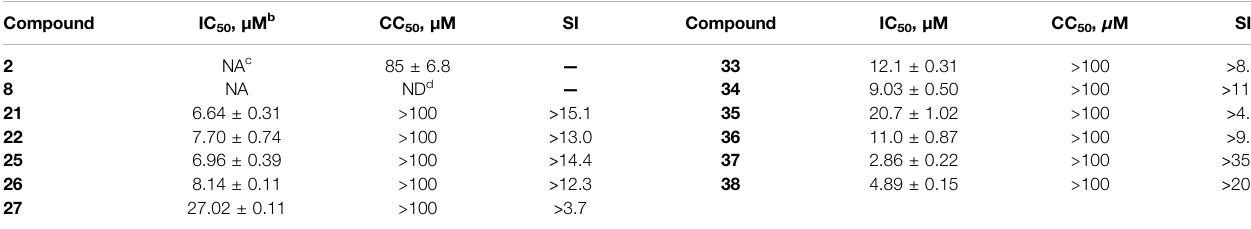
TABLE 2 | In vitro anti-in fl uenza A virus activity of GA (2) , β -CD (8) and their heptavalent conjugates 21 – 22, 25 – 27 and 33 – 38 a .